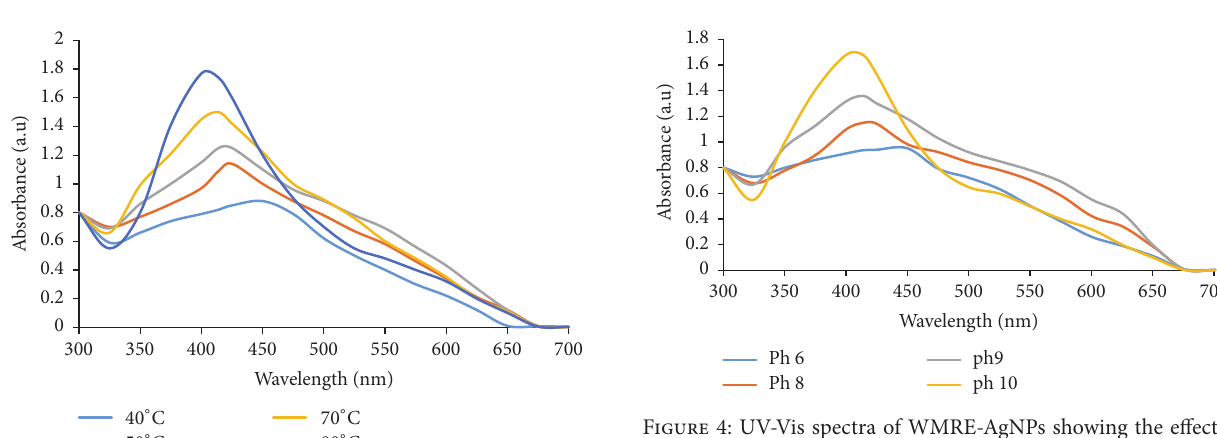
Figure 4: UV-Vis spectra of WMRE-AgNPs showing the effect of variation of pH on WMRE-AgNPs